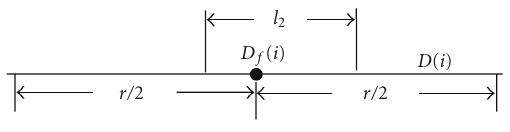
Figure 15: Bit filtering when l 2 < r/